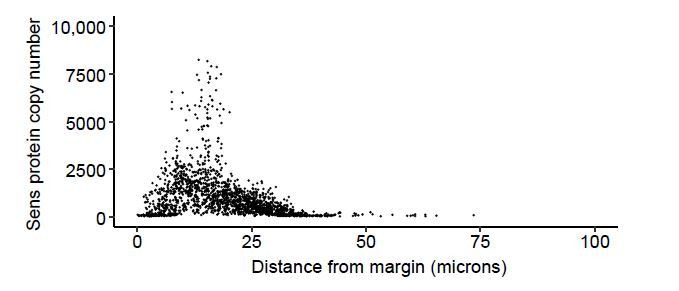
Scatterplot of Sens concentration as a function of distance of a cell from the DV boundary.Shown is data from one disc and each datapoint is a single cell.